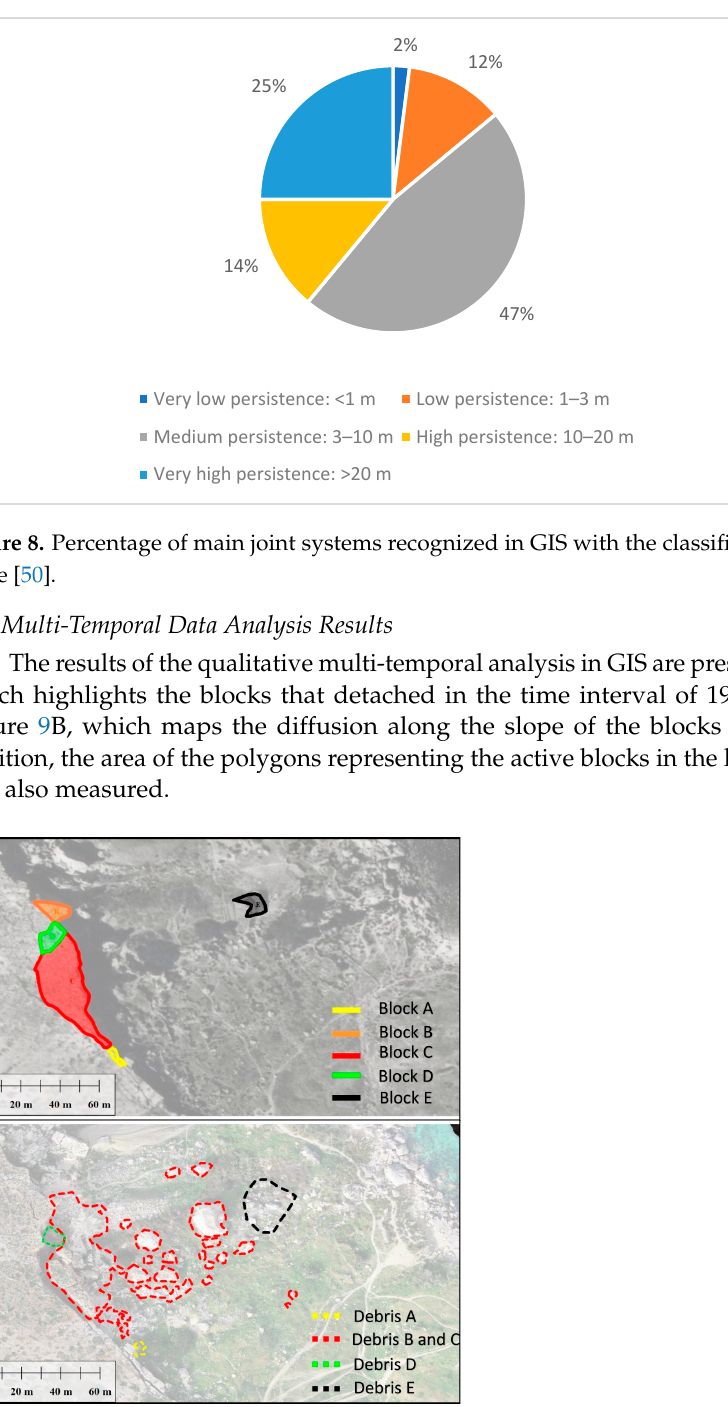
Figure 9. Results obtained with the multitemporal analysis. ( A ) Aerial photo from 1957 in which the blocks that will move in the next sixty-four years were mapped. ( B ) Orthomosaic obtained from UAVs [1] in which the areas covered by the debris of the blocks that detached between 1957 and 2021 are mapped. Block ‘E’ lay on the slope in 1957 and that was shattered by the probable impact of rolling boulders from blocks ‘B’ and ‘C’ between 1988 and